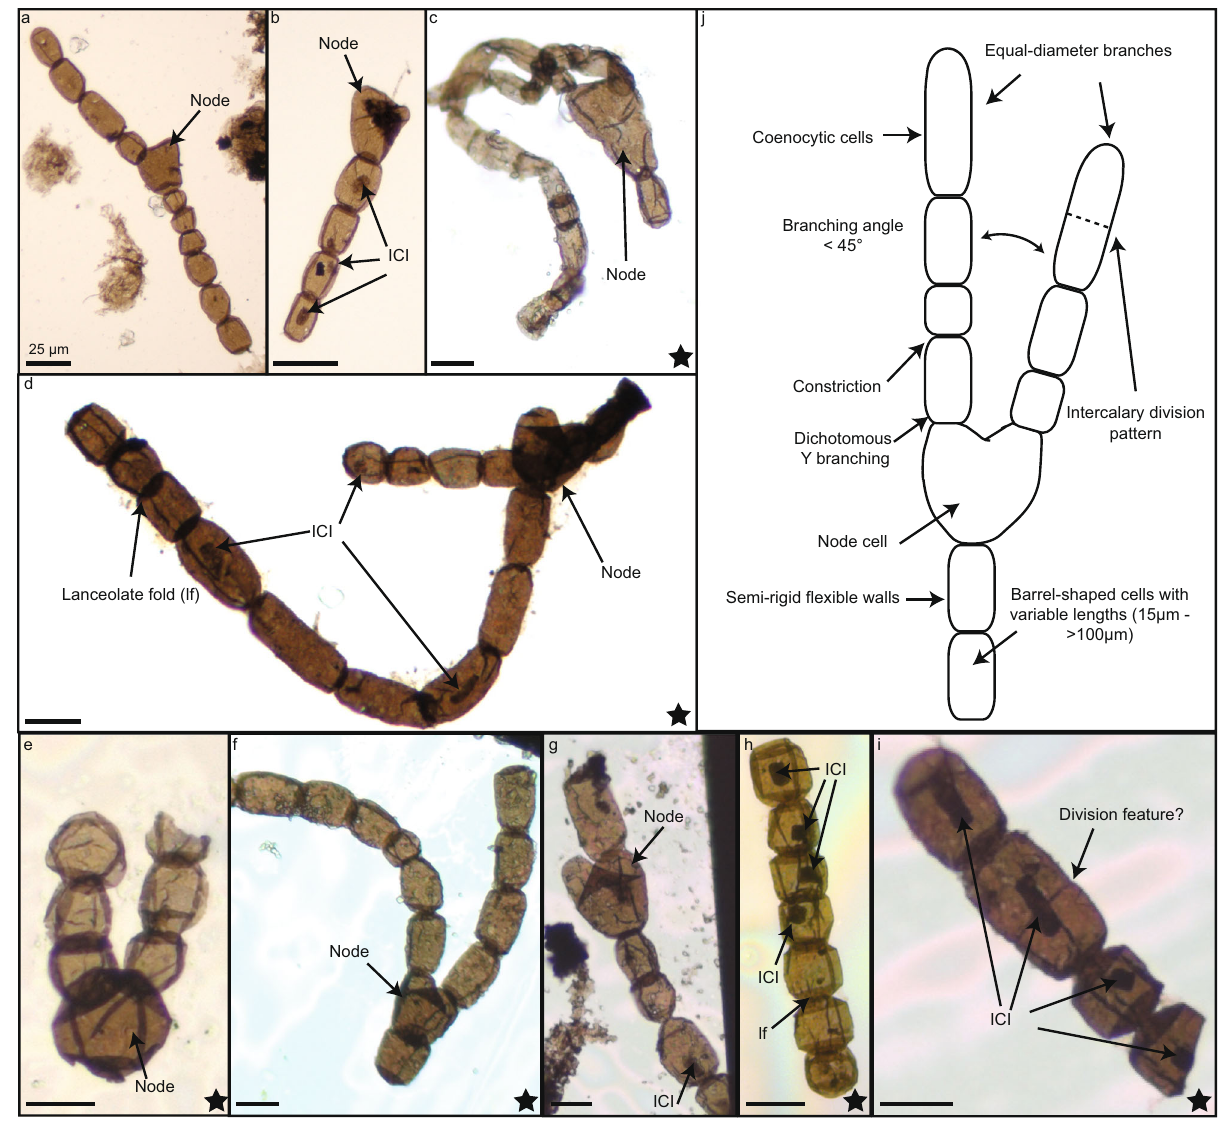
Fig. 1 Microphotographs of A. tetragonala specimens. a – g Branched specimens with node cell, equal-diameter branches, lanceolate folds (lf), and intracellular inclusions (ICI). h , i Uniseriate fi laments of the microfossils j , Sketch of A. tetragonala , displaying the main features of the microfossil. Black stars correspond to specimens that have been analysed by SR-